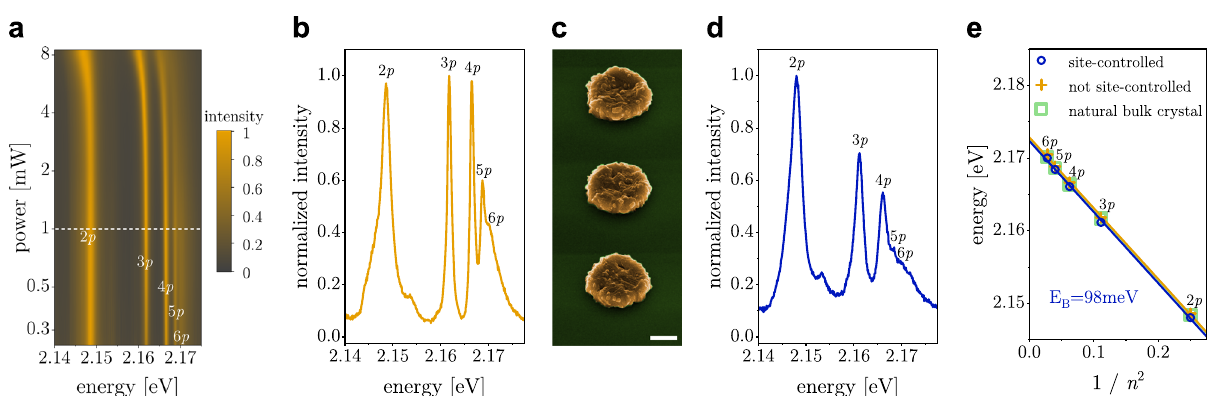
Fig. 3 Rydberg excitons in Cu 2 O microcrystals and site-controlled structures. a Normalized photoluminescence of np Rydberg exciton emission from Cu 2 O microcrystal for varying excitation powers. The white dashed line indicates the spectrum presented in b which was acquired at an excitation power of 1 mW and a cryostat stage temperature around 1.8 K. c Scanning electron micrograph of site-controlled circular Cu 2 O microstructures with 5 μ m diameter (scale bar 2 μ m; sample tilt 45°). d Photoluminescence spectrum of site-controlled Cu 2 O microstructure that was acquired under identical experimental conditions as in b . e Rydberg exciton energies as a function of n − 2 and the corresponding linear fi ts to extract the exciton binding energy E